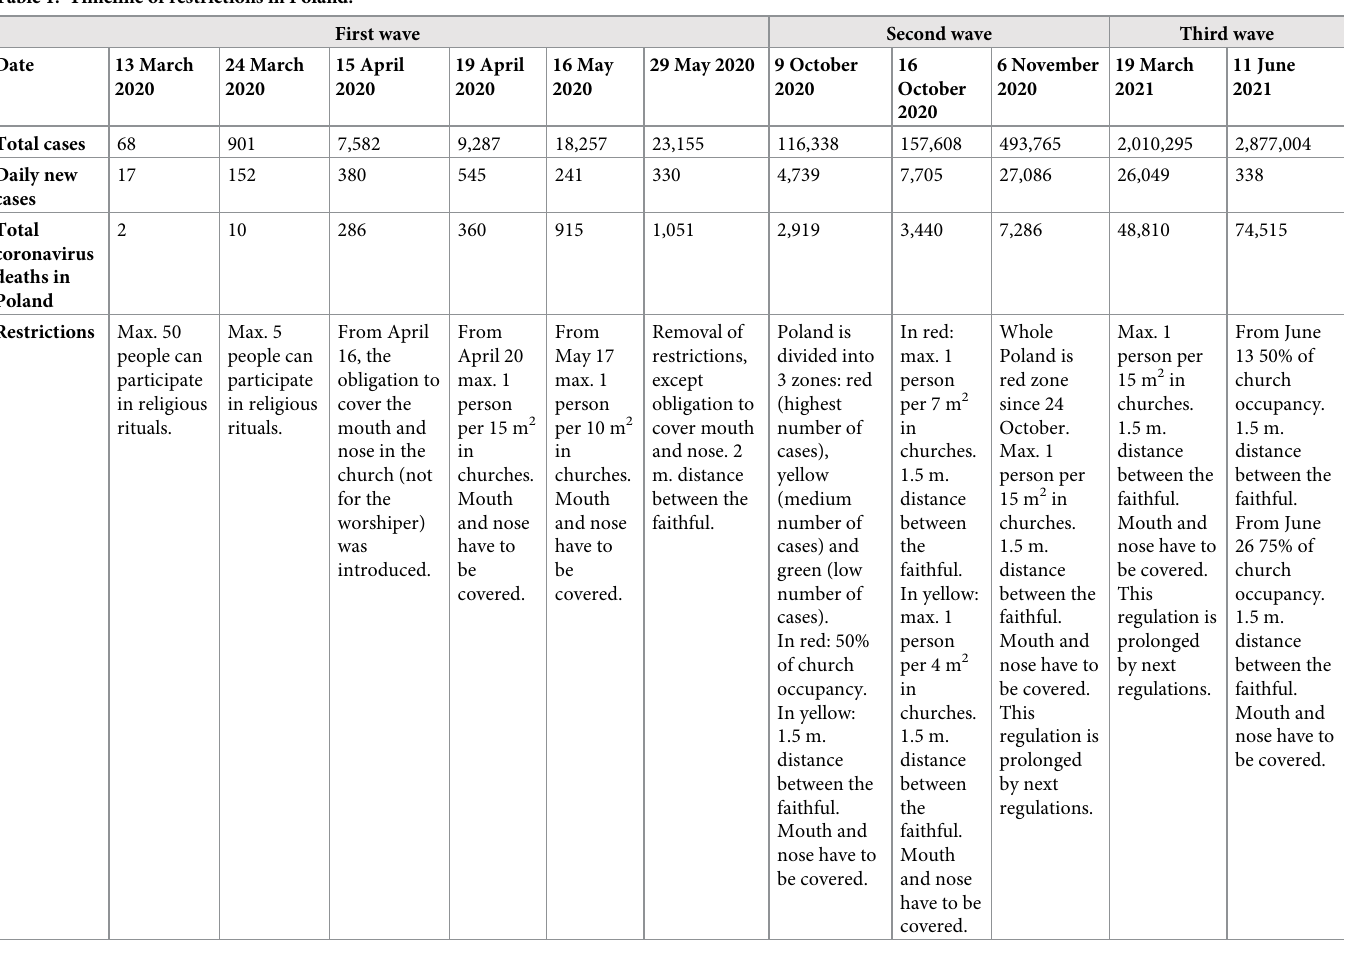
Table 1. Timeline of restrictions in